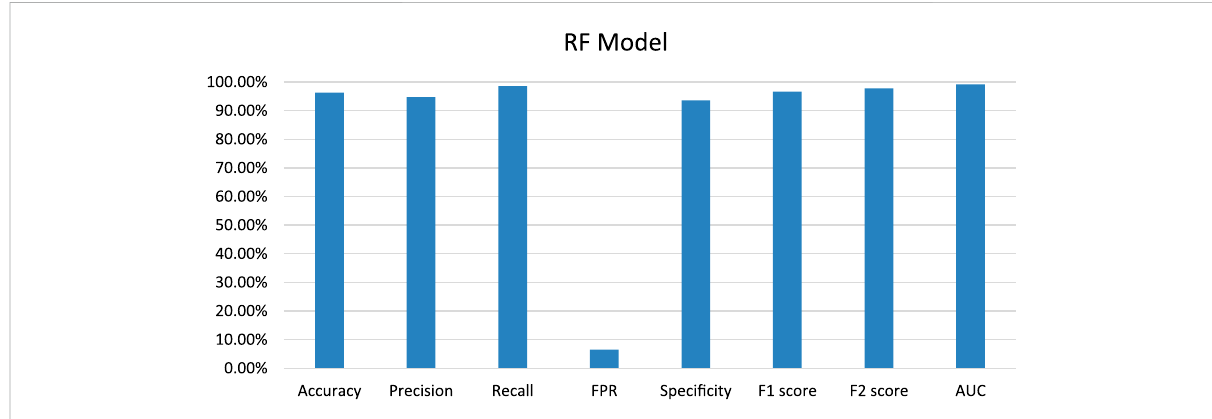
FIGURE 5 Graphical representation of developed Random Forest model performance based on evaluation parameters.